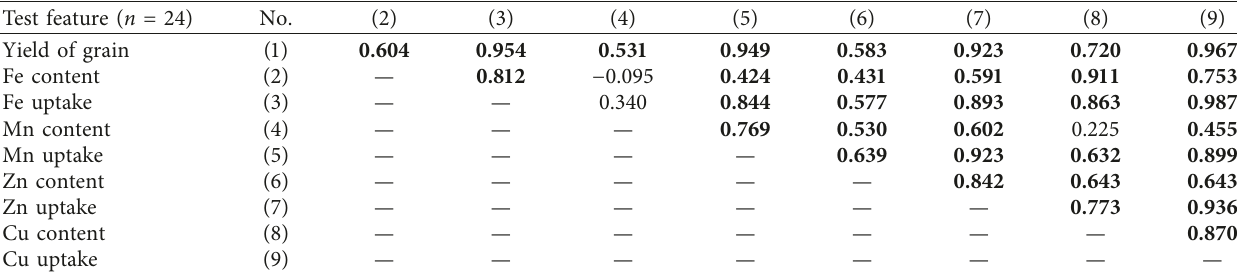
Table 8: Correlation coefficients between grain yield and content and uptake of micronutrients. Test feature ( n �